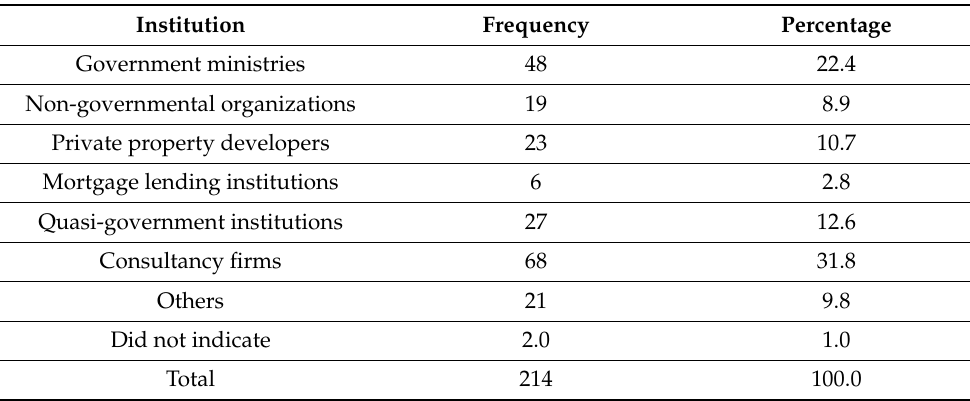
Table 2. Organizations or institutions